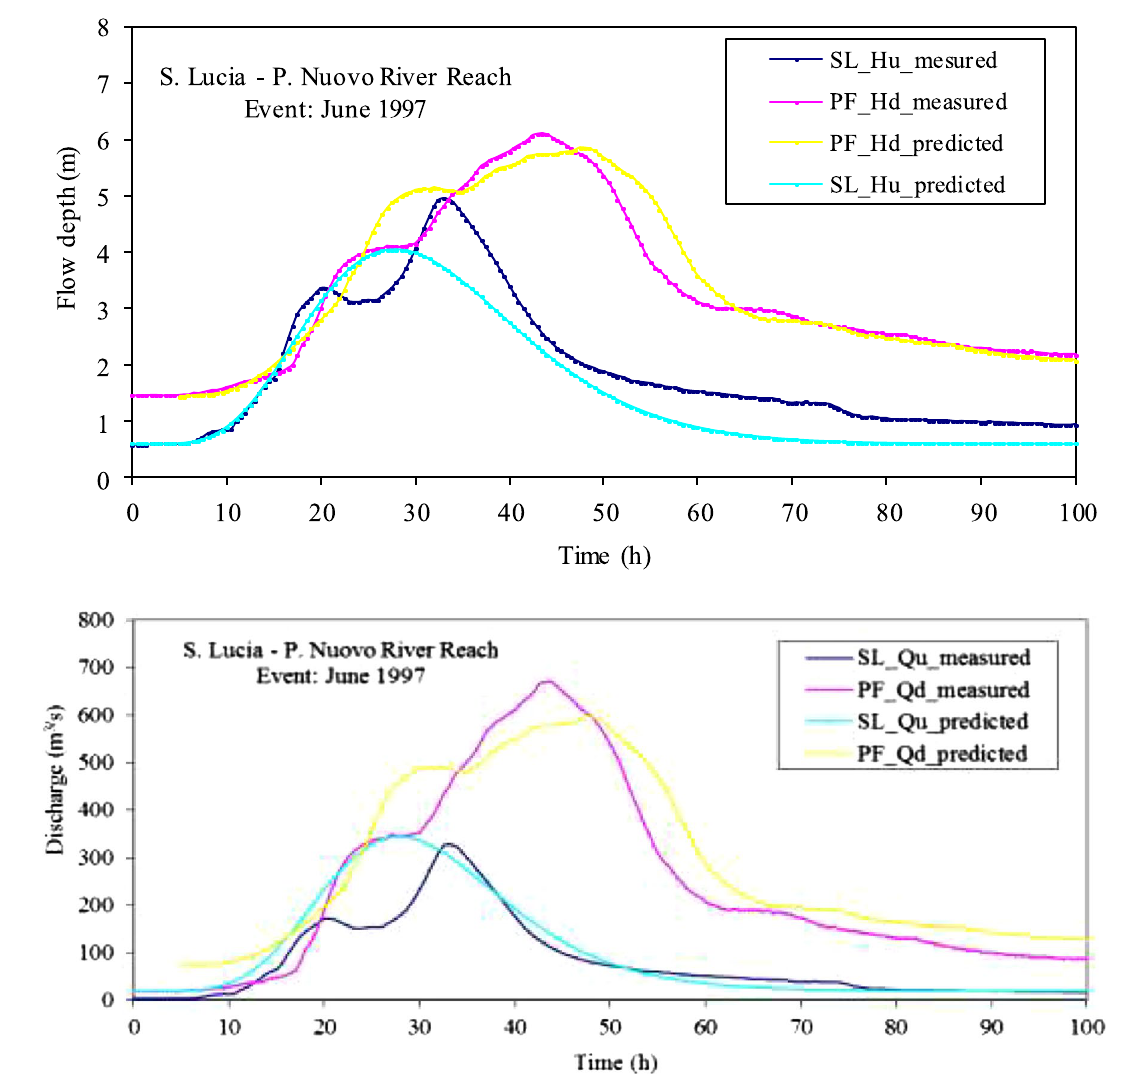
Fig. 5 Flow stage (above) and flow discharge (below) hydrograph simulations for event June 1997 in S. Lucia and P. Nuovo river